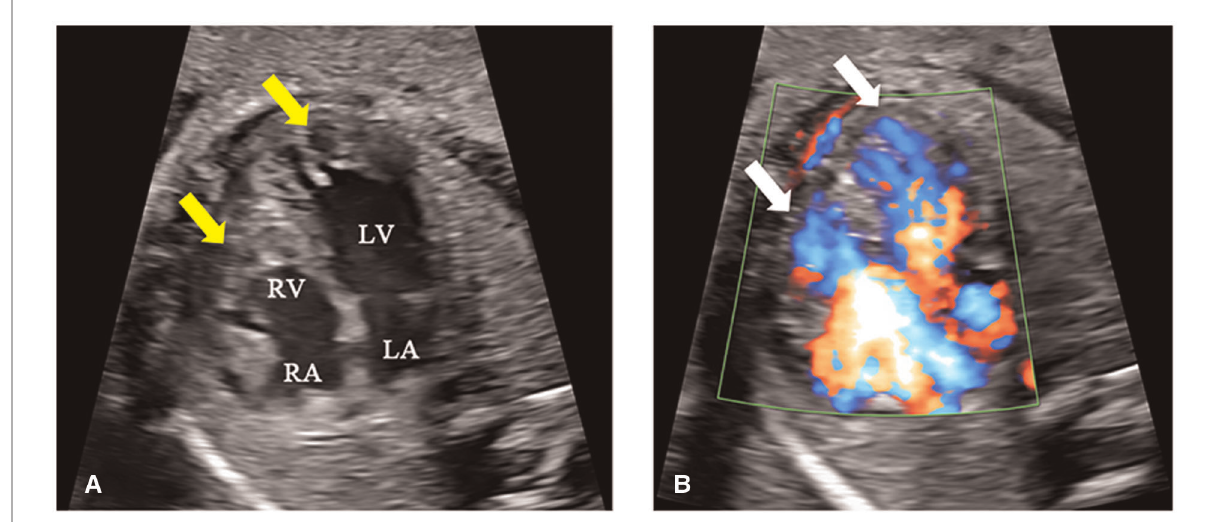
FIGURE 1 Fetal echocardiography at 25 +1 weeks of gestation. ( A ) The two-dimensional ultrasound image shows increased numbers of prominent trabeculations and deep intertrabecular spaces in both ventricles (yellow arrow), especially at the left ventricular apex. The ratio of non- compaction (6 mm) to compaction (2 mm) was 3:1. ( B ) The color Doppler ultrasound image shows blood perfusing the intertrabecular recesses (white arrow). LA, left atrium; LV, left ventricle; RA, right atrium; RV, right